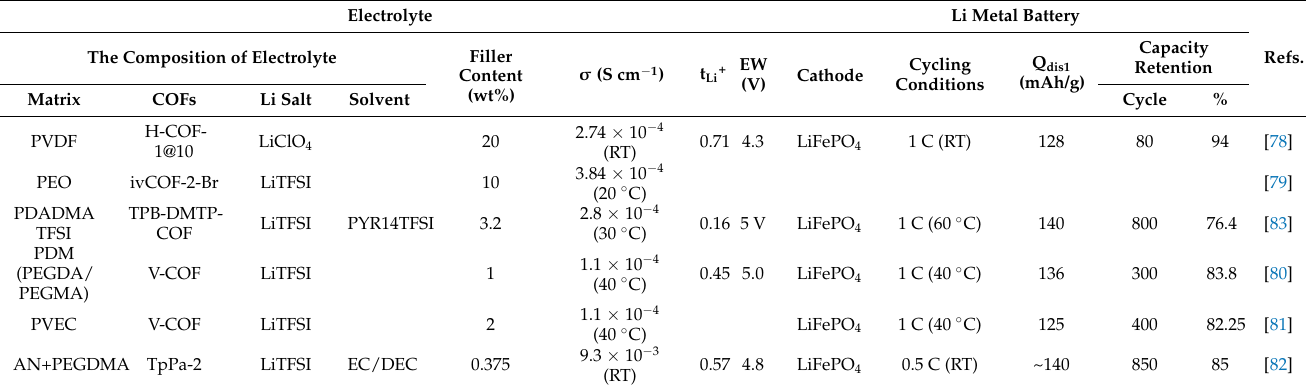
Table 2. Summary of the major performances of SSEs with COF